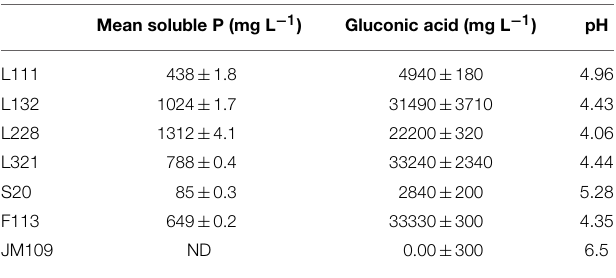
TABLE 2 | Phosphate solubilization, gluconic acid production, and pH values of endophytic strains in NBRIP broths (means ± standard deviations, n = 3 ) ND, Not